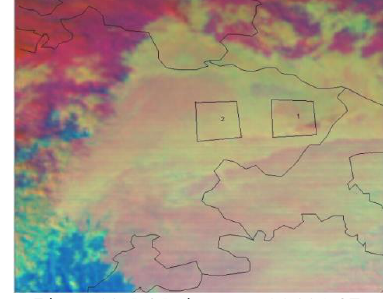
Figure 12. RGB image at 14:30 LST